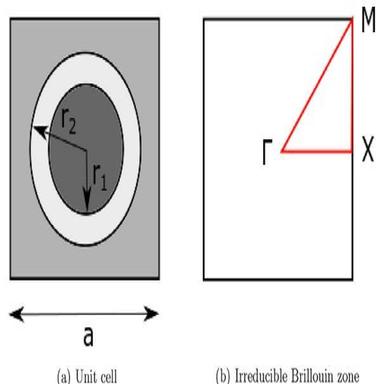
Geometry of the unit cell and representation of the irriducible Brillouin zone .